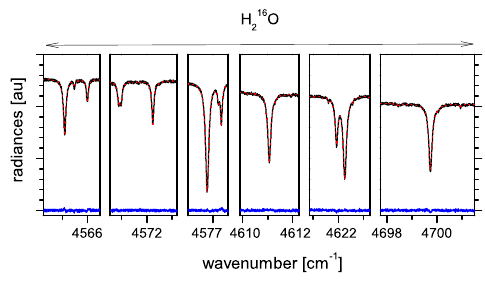
Fig. 3. Same as Fig. 1 but for the 2650 - 3180 cm − 1 retrieval.